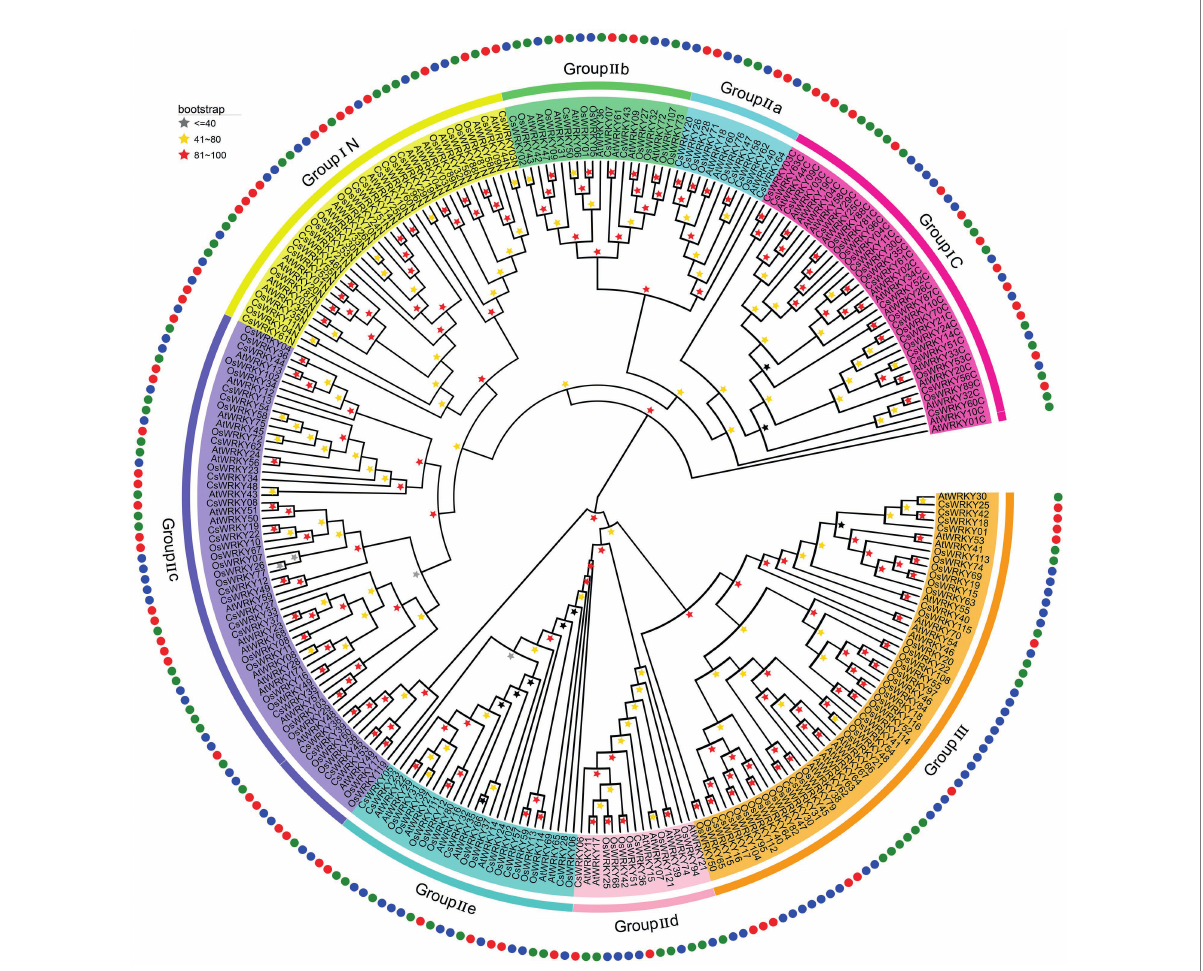
FIGURE 1 Phylogenetic tree of WRKY genes in Cymbidium sinense (Cs), Arabidopsis thaliana (At), and Oryza sativa (Os). An individual group (I–III) of ancestral relationships were presented in different